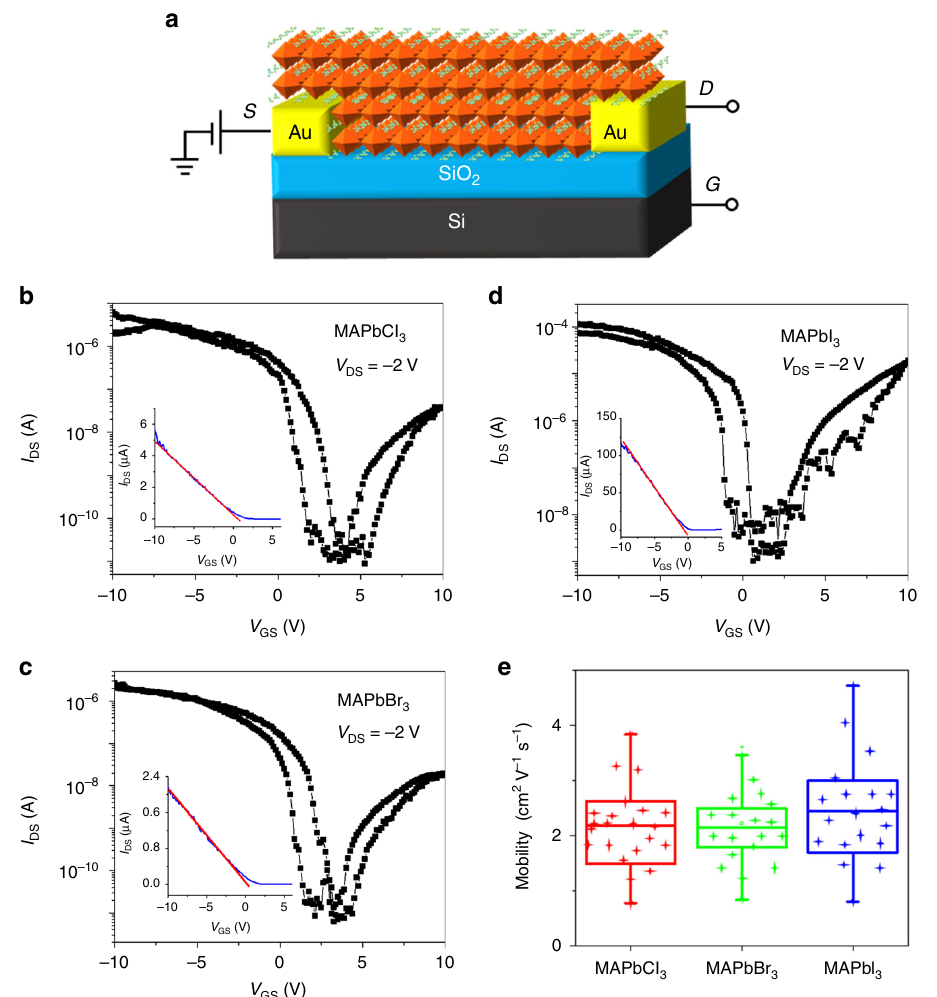
Fig. 4 Characteristics of bottom-contact TSC-FETs. a Schematic representation of bottom-gate, bottom-contact (BGBC) TSC-FET device. Representative transfer characteristics of TSC-FETs of b MAPbCl 3 , c MAPbBr 3 , and d MAPbI 3 using forward/reverse gate voltage sweeps from − 10 to 10 V at a rate of 0.05 V s − 1 , with V DS = − 2 V. Insets of b – d show the linear regime of the respective devices. e Field-effect hole mobility distribution for 20 devices